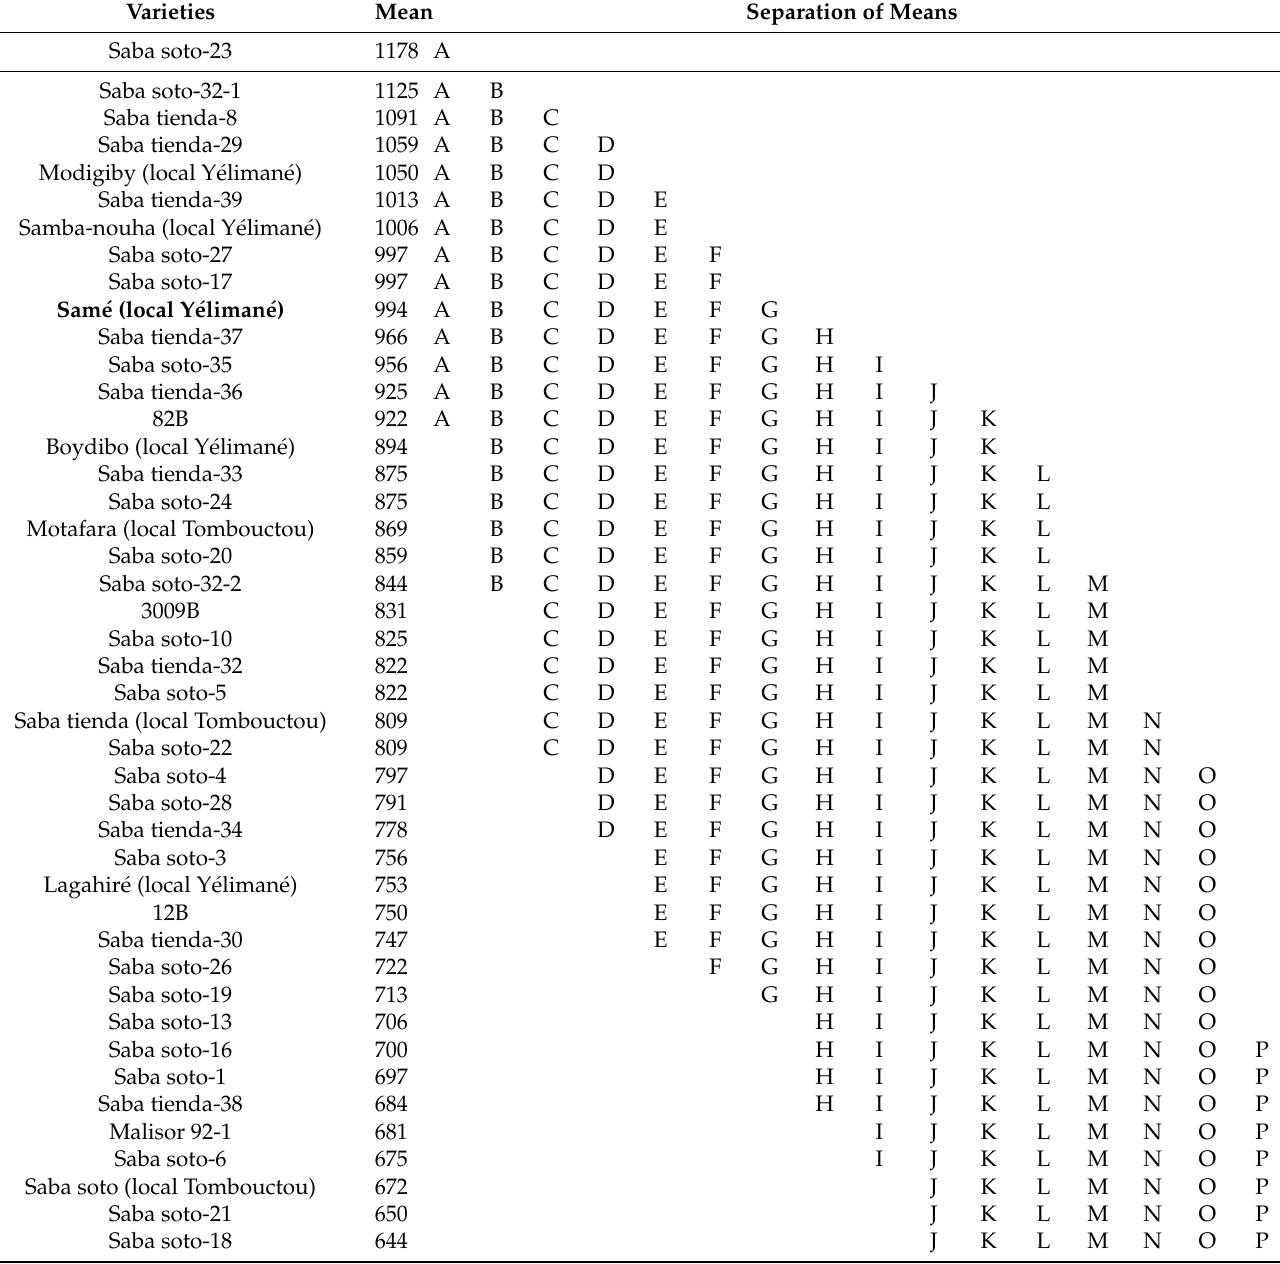
Table 2. Average sorghum grain yield (kg ha − 1 ) across sites of flood recession farming for 54 varieties tested in Yaguine, Gory, and Foungou in the 2013/2014 cropping